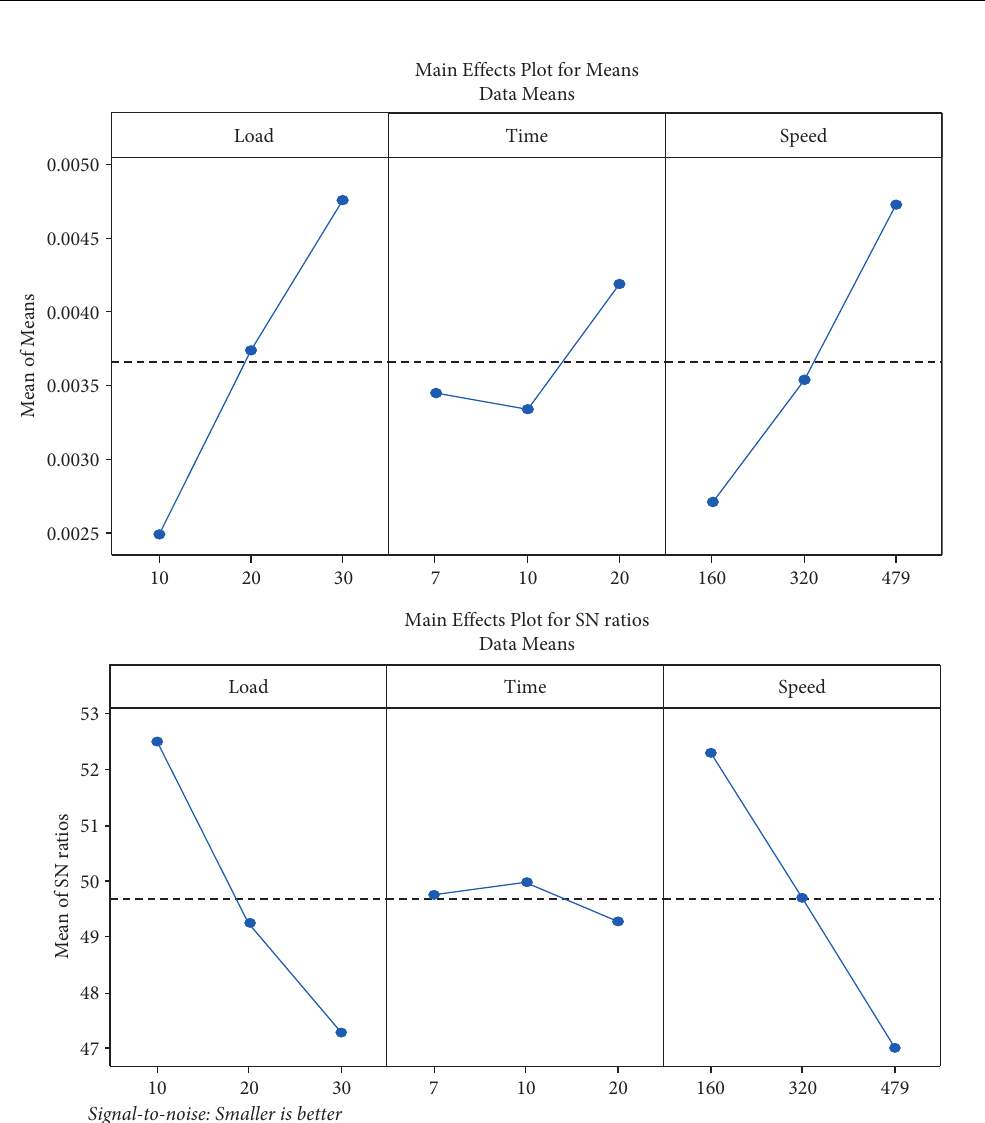
Figure 5: Main effect plots for means and SN